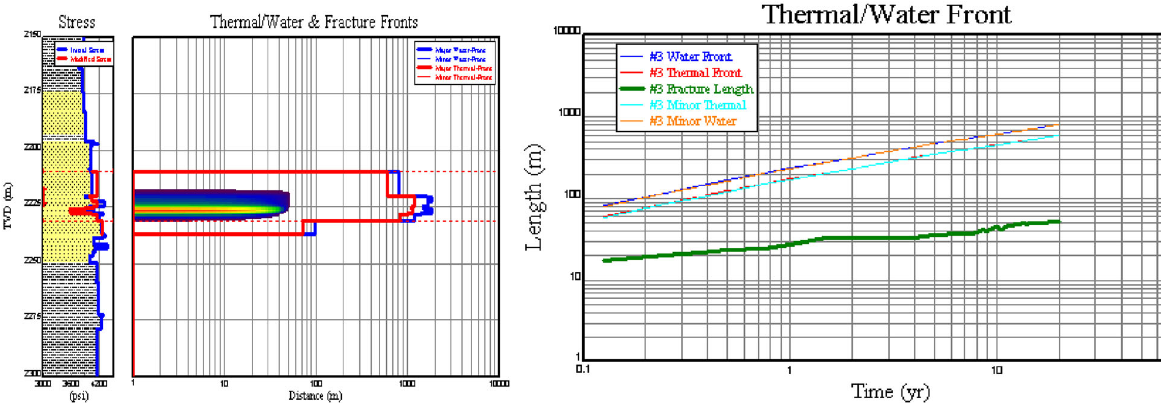
Fig. 20 PERFTOP case fracture height versus time